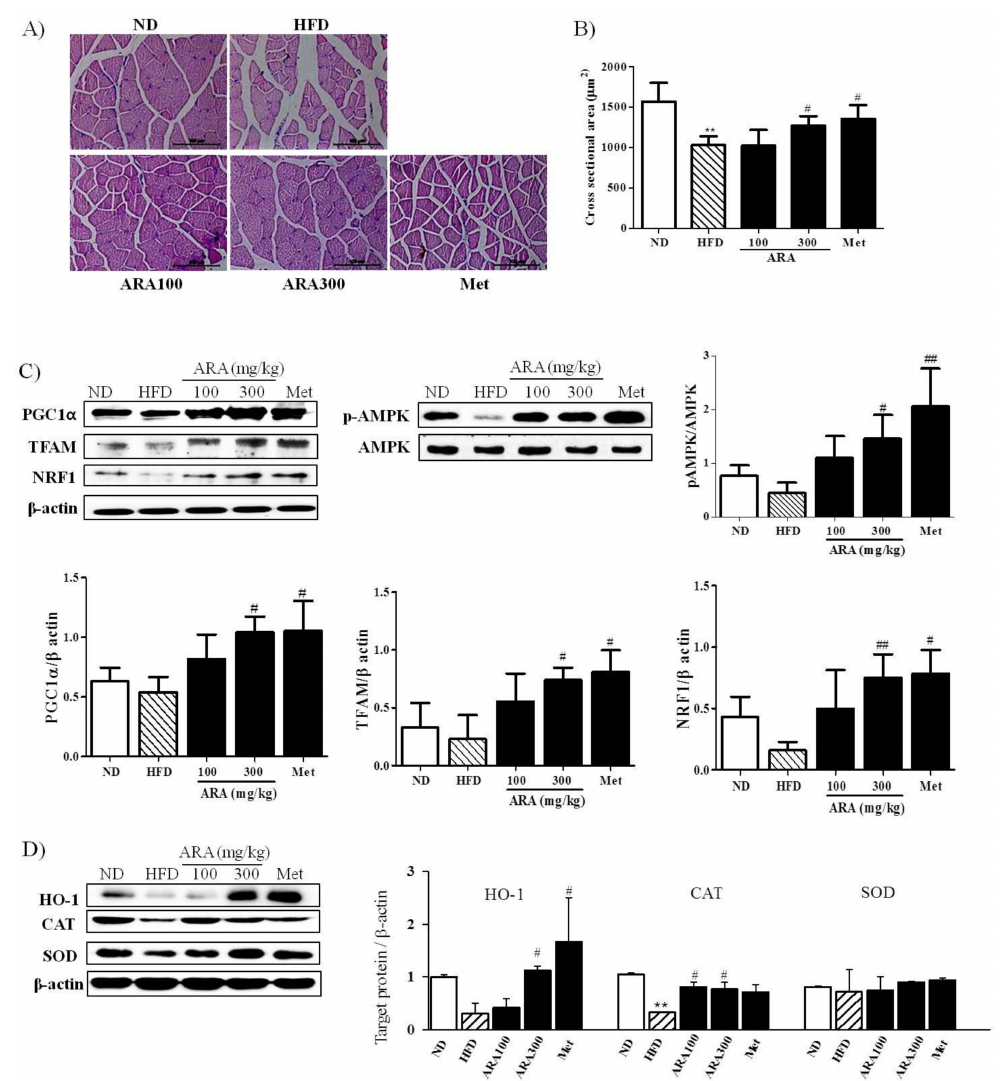
Figure 4. Effects of ARA on energy metabolism in skeletal muscle. ( A ) muscle fiber morphologies of gastrocnemius muscle, original magnification 400 × , Scale bar: 50 µ m.; ( B ) cross-sectional area of muscle fibers; ( C ) PGC1 α , TFAM, NRF1 and pAMPK protein levels in skeletal muscle tissues; ( D ) HO-1, SOD and CAT protein levels in skeletal muscle tissues. Results are presented as means ± standard errors of the mean (SEM) ( n = 3). ** p < 0.01 versus normal chow fed controls (the ND group); ## p < 0.01, # p < 0.05 versus the high fat diet fed mice (the HFD group). PGC1 α , peroxisome proliferator-activated receptor gamma coactivator 1 alpha; TFAM, mitochondrial transcription factor; NRF1, nuclear respiratory factor 1; AMPK, adenosine monophosphate-activated protein kinase; HO-1, Heme oxygenase-1; SOD, superoxide dismutase; CAT,